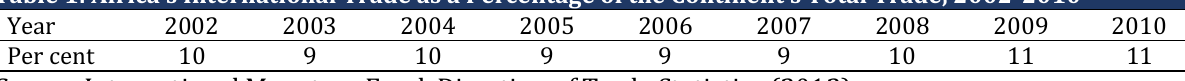
Table 1: Africa’s International Trade as a Percentage of the Continent’s Total Trade,